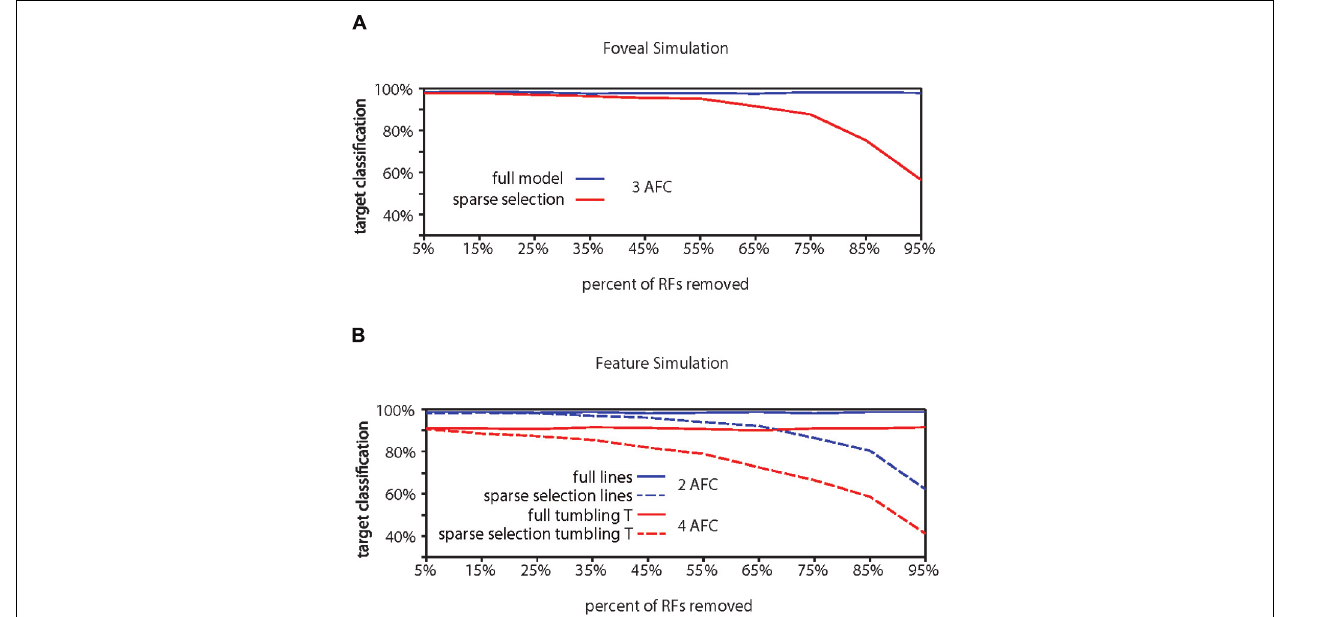
discrimination task (91.06%) in the presence of flankers (solid lines). Sparse selection of feature-tuned receptive fields leads to a monotonic decrease in performance and crowding of features (dashed blue), showing that the model predicts crowding at any behaviorally relevant level of processing. Sparse selection occurs at only in the perceptual readout from one level and not in the information passed between levels, avoiding the degradation of object level encoding that would occur if object representation depended on the sparse selection of features (shown in dashed